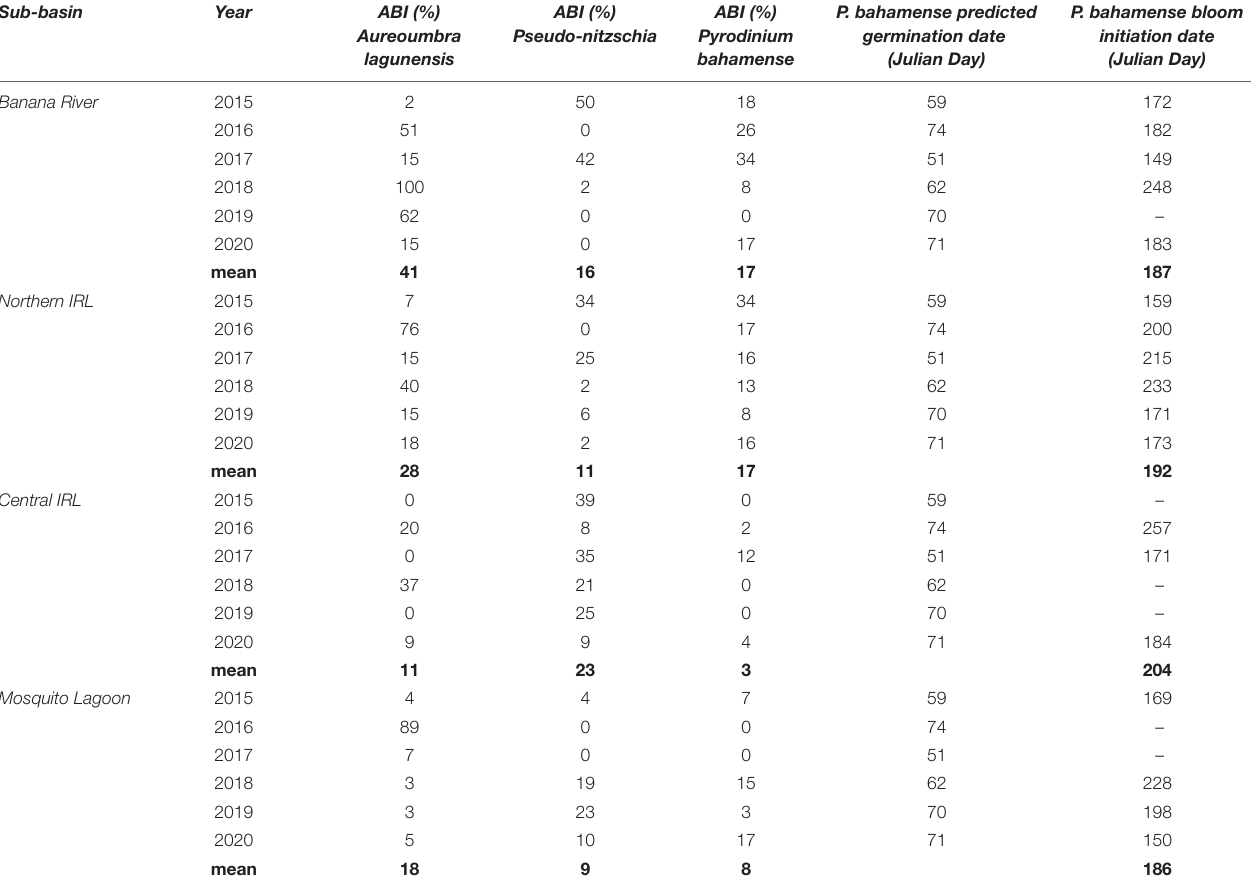
TABLE 2 | Annual bloom index (ABI) for different taxa, sub-basins, and years are shown. Sub-basin Year